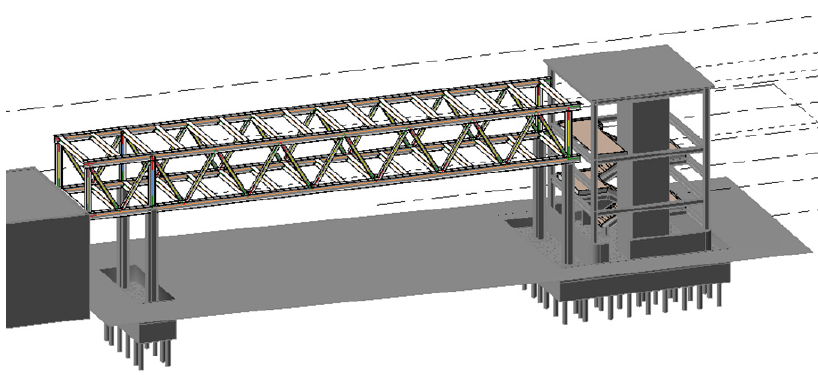
Figure 5. Reticular structure model.